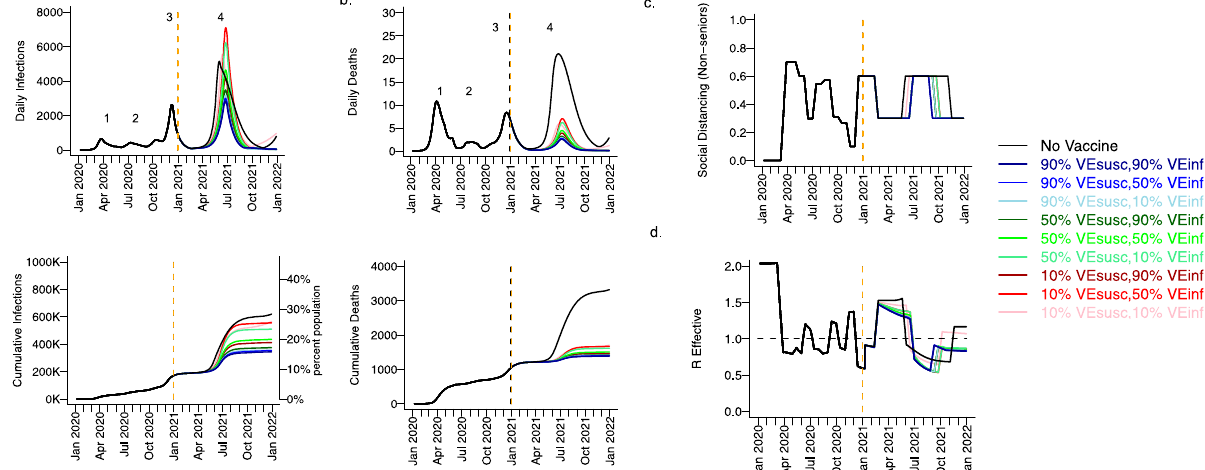
Figure 6. High VE SUSC or high VE INF limit the extent of a fourth wave at low vaccine roll out rates with the B.1.1.7 variant. For unvaccinated (black lines) and each vaccine cohort (colored lines, legend), we project ( a ) infections, ( b ) deaths, ( c ) social distancing relative to pre-pandemic levels and ( d ) the effective reproductive number. The first two columns ( a , b ) are organized by row: top = daily incidence, bottom = cumulative. Waves of infection are numbered 1-4. Six combinations of VE SUSC and VE INF are considered while VE SYMP is fixed at 90% such that all vaccines would produce results consistent with those in the Pfizer and Moderna trials. High VE SUSC (90%) simulations are blue. Moderate VE SUSC (50%) simulations are green. Low VE SUSC (10%) simulations are red/pink. Dark lines are high VE INF (90%). Light lines are low VE INF (10%). The largest reduction in cases is associated with either high VE SUSC or VE INF . 5000 people are fully vaccinated per day starting 1 January 2021 (orange dotted vertical line) until 90% are vaccinated in age groups other than children. Case threshold for reinstituting physical distancing to 0.6 is 350 per 100,000 over two weeks and for relaxation is 100 per 100,000. 80% of vaccines are initially allocated to the elderly.